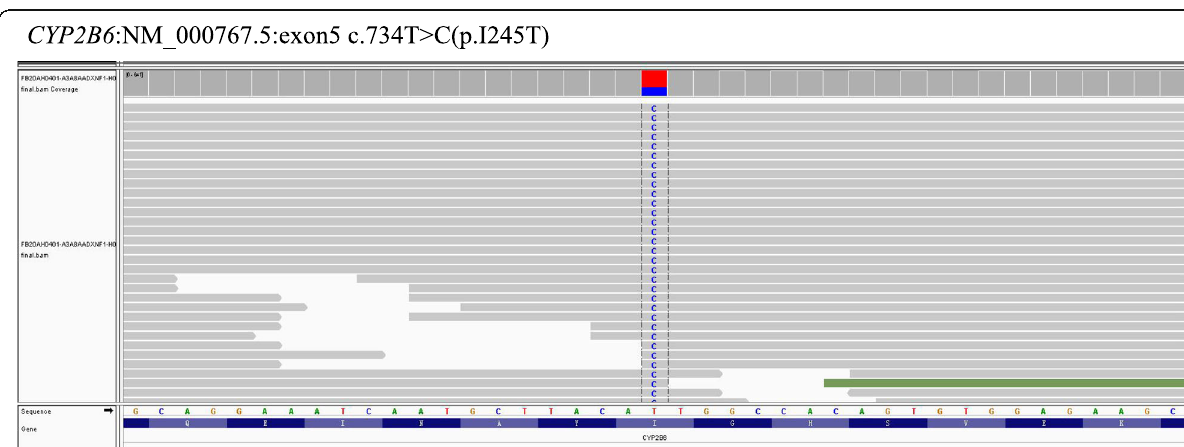
Fig. 4 Integrative Genomics Viewer (IGV) split-screen view of read alignments of the identified mutations of CYP2B6 :NM_000767.5: exon5 c.734T > C(p.I245T) in case